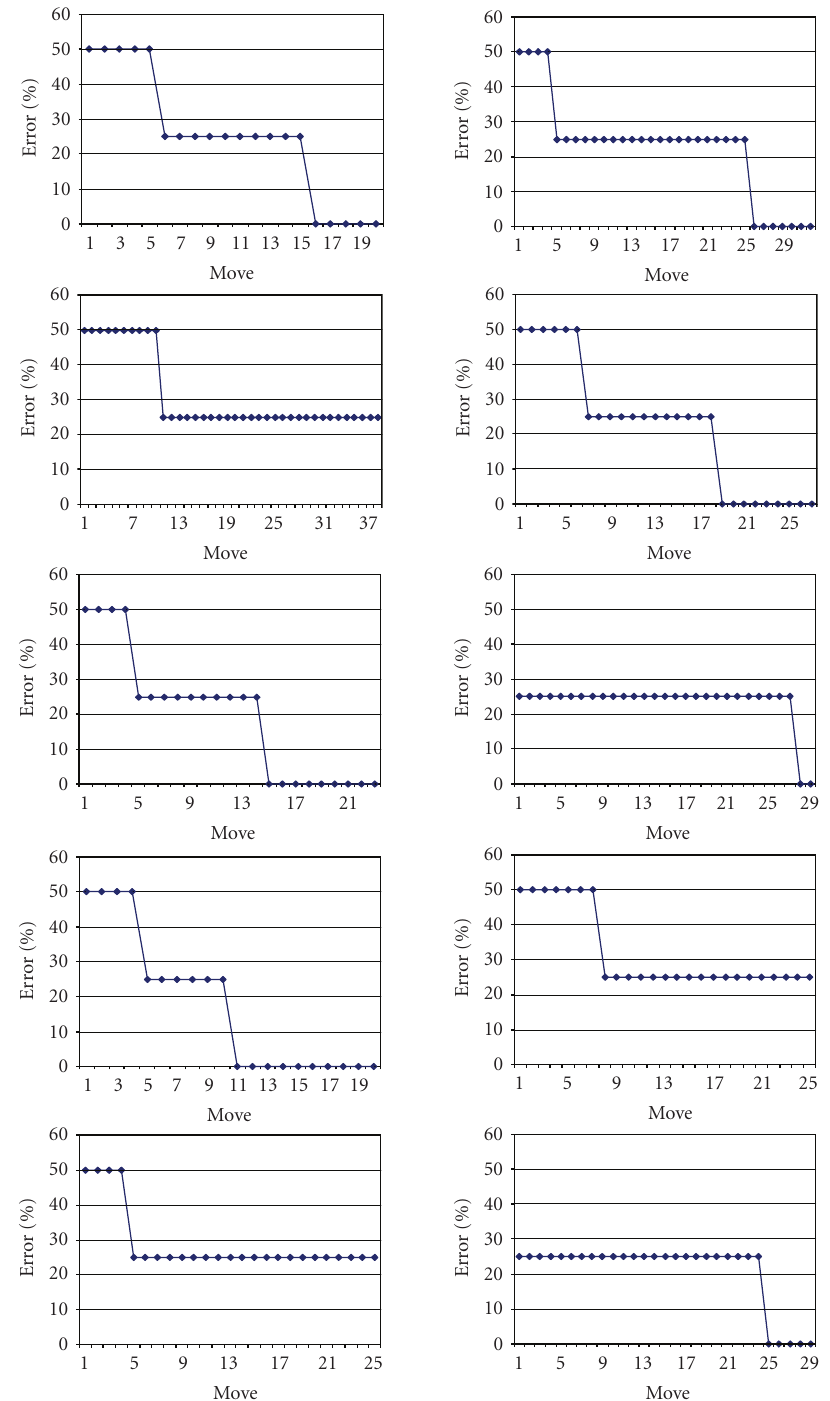
Figure 5: Percentage of error of the prototype-based machine learning algorithm (proportion of times a type of a piece on the board is wrongly predicted) for 10 di ff erent game sessions. The x -axis represents the moves of the player during that game session (the number of moves for a game varies on di ff erent game